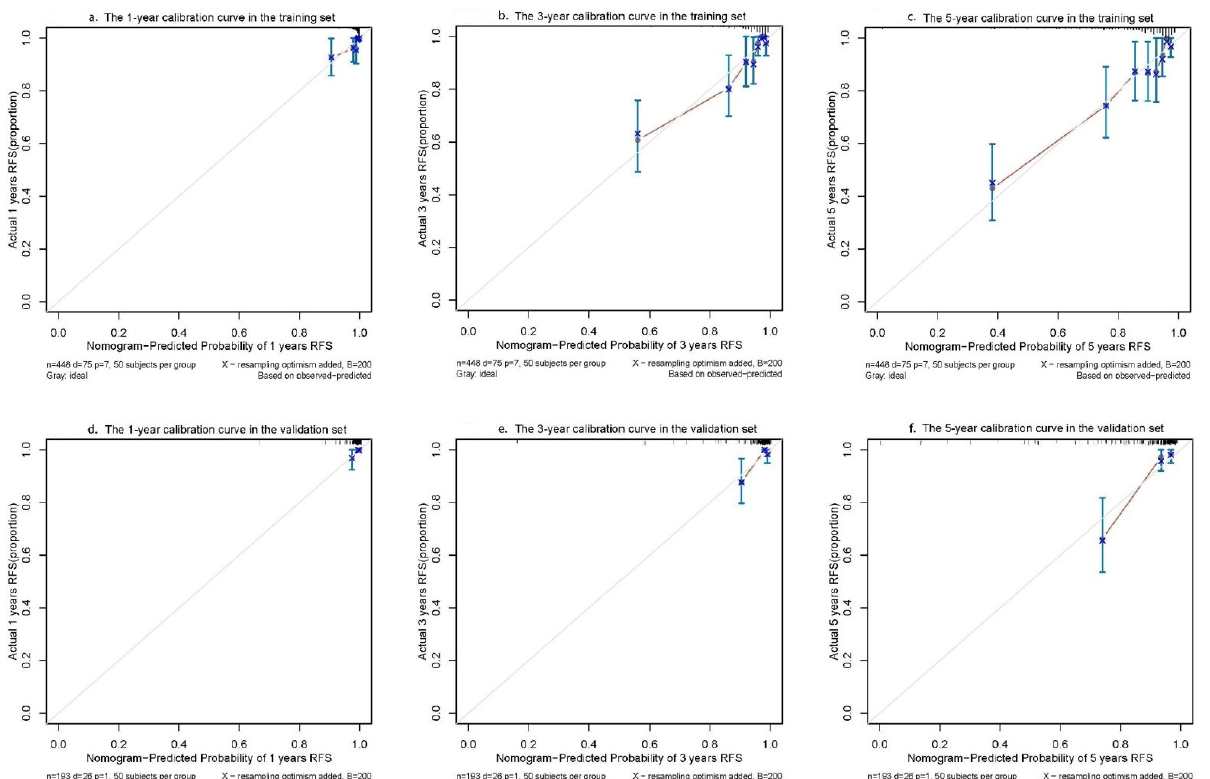
Figure 6. Calibration plots for the training and validation sets that show the predicted and observed RFS rates. ( a ) The 1-year calibration curve in the training set. ( b ) The 3-year calibration curve in the training set. ( c ) The 5-year calibration curve in the training set. ( d ) The 1-year calibration curve in the validation set. ( e ) The 3-year calibration curve in the validation set. ( f ) The 5-year calibration curve in the validation set.